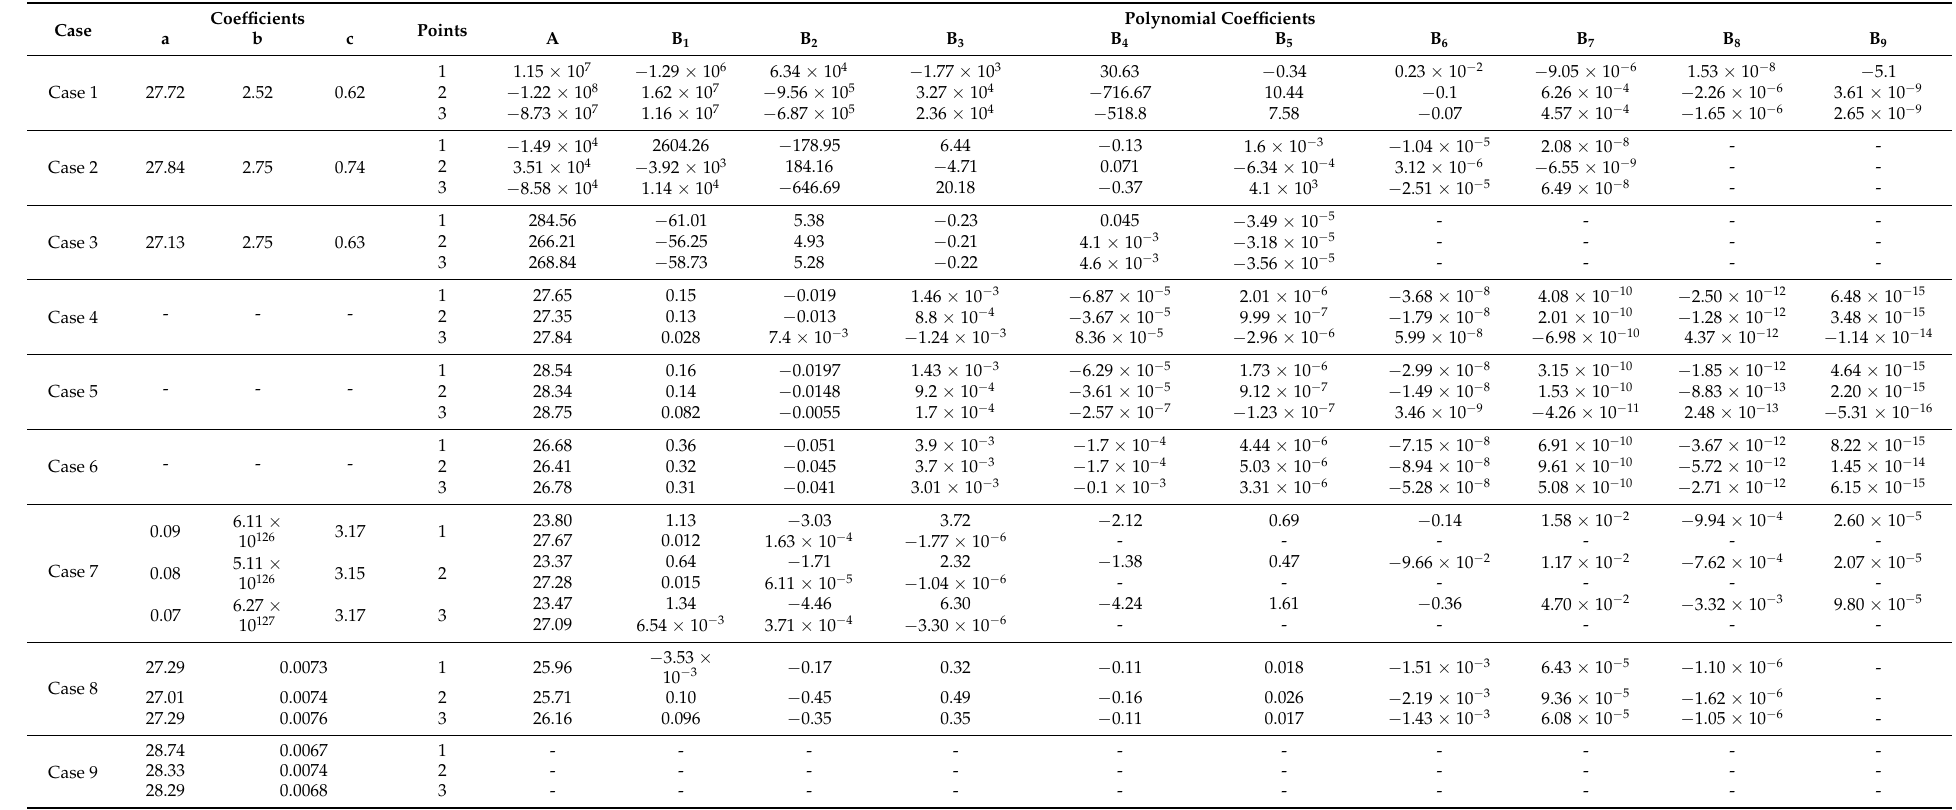
Table 9. Coefficients of the fitting formulae in cases